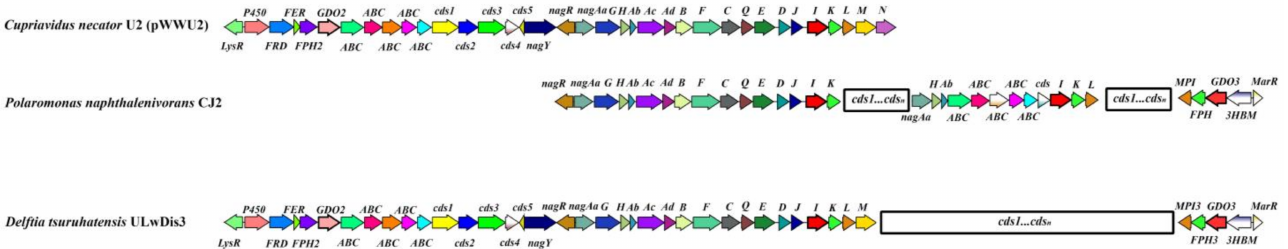
Figure 2. Comparison of the genomic region of the gentisate 1.2-dioxygenase gene in